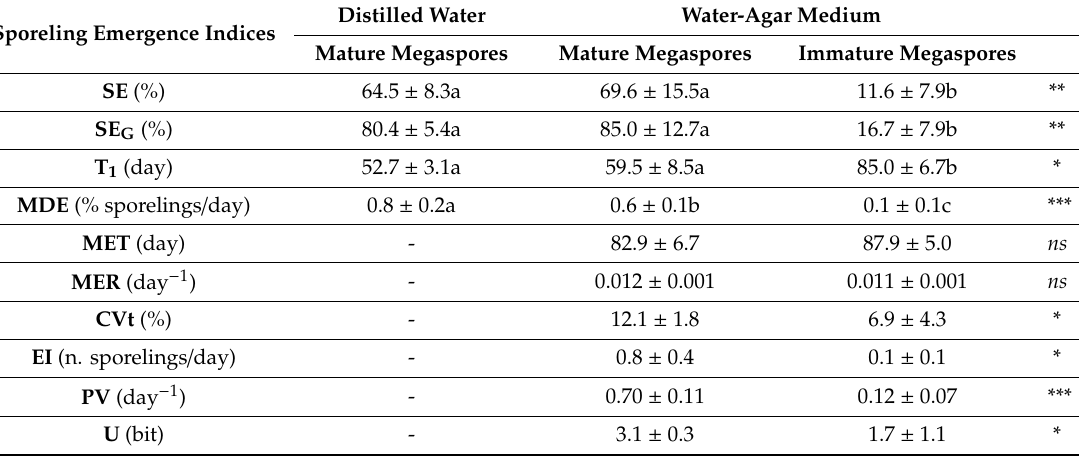
Table 2. Indices for the evaluation of sporeling emergence from mature and immature megaspores of Isoëtes sabatina in water-agar cultures. SE: sporeling emergence percentage, calculated for the total number of sown megaspores; SE G : sporeling emergence percentage, calculated on the total number of the germinated megaspores; T 1 : time for first sporeling emergence; MDE: mean daily emergence; MET: mean emergence time; MER: mean emergence rate; CVt: Coe ffi cient of variation of emergence time; EI: emergence index; PV: peak value; U: uncertainty of the sporeling emergence process. All values are reported as mean ± SD; values followed by the same letter are not significantly di ff erent at the 5% level of probability, as determined by Dunn’s test. Significance determined by 1-way ANOVA or Kruskal–Wallis test (SE, SE G